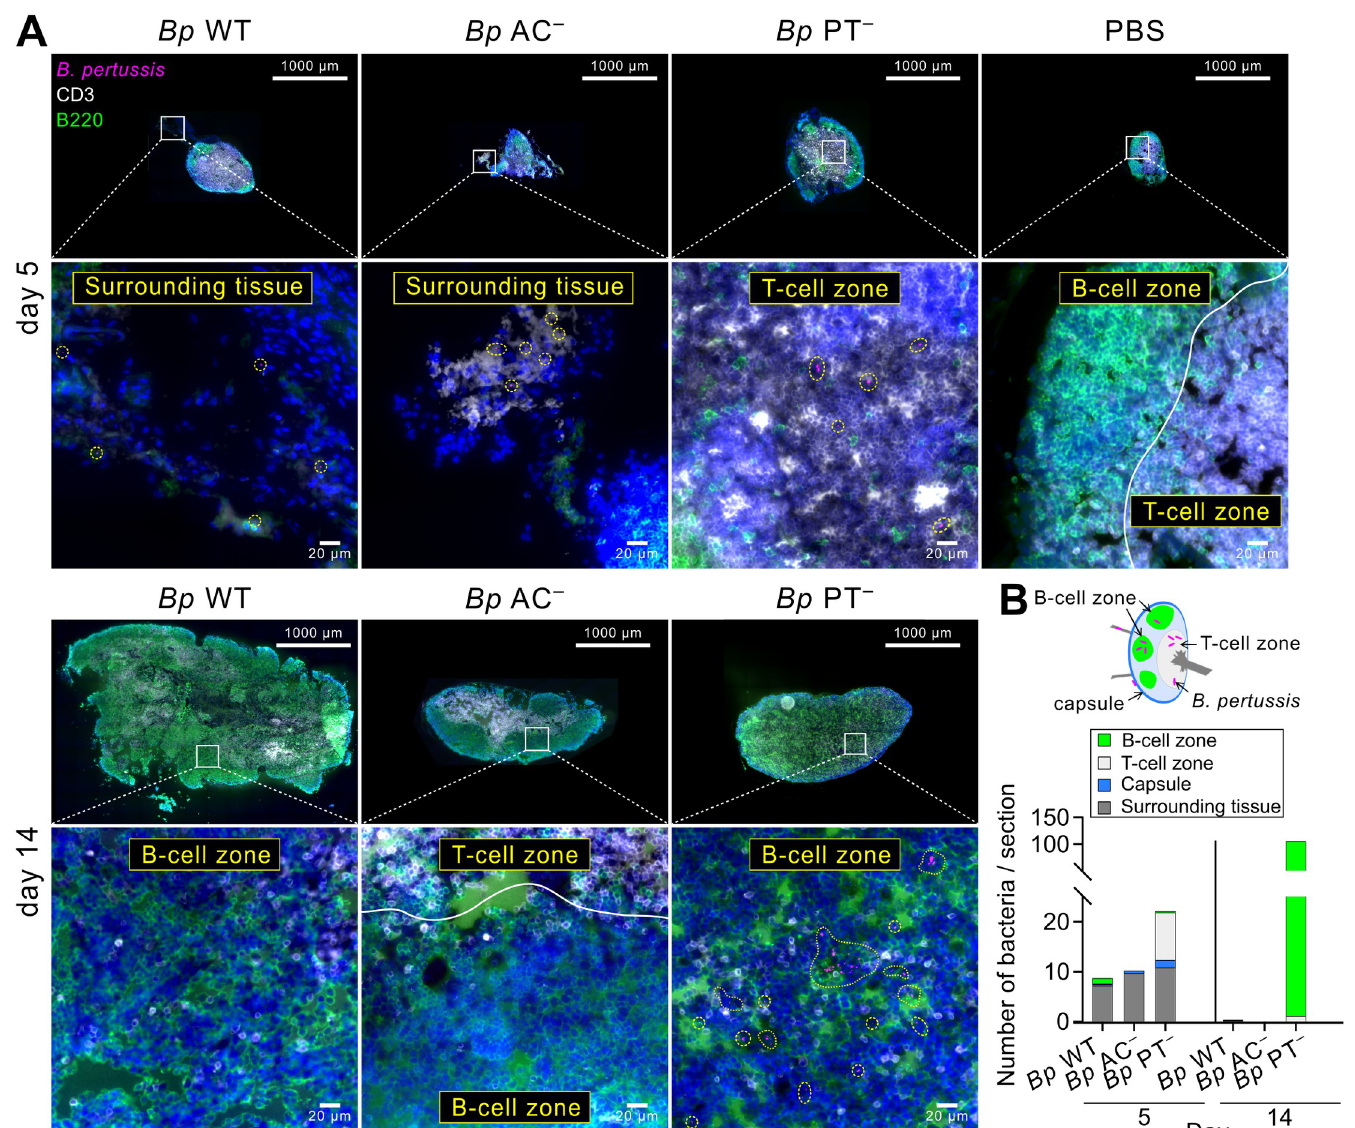
Fig 4. PT-producing B . pertussis does not enter the lymphoid tissue of mLNs, whereas Bp PT − bacteria enter the T-cell zone and expand in the B-cell zone of mLNs. (A) Immunofluorescence microscopy of cryosections of mLNs of infected mice on days 5 (upper panel) and 14 (lower panel). mLNs were fixed with 4% PFA, snap frozen and 10 μ m longitudinal cryosections were first labeled with rat anti-mouse CD45R (B220), followed by goat anti-rat Alexa Fluor 488 secondary antibody conjugate and finally by Alexa Fluor 647 rat anti-mouse CD3 antibody conjugate. Nuclei were labeled with DAPI. Stitched images were acquired at 40x magnification using an Olympus IX83 motorized automated microscope. Upper panels show representative images of entire mLN sections (scale bar 1000 μ m). The white squares locate the zoomed-in areas shown in lower panels (see S6, S7, S8 and S9 Figs for high resolution images). Lower panels depict the details of the indicated areas (scale bar 20 μ m). The mScarlet- expressing bacteria are encircled by yellow dotted lines. T cells, B cells, nuclei and bacteria are rendered in white, green, blue and magenta colors, respectively. In total 8 mLNs from three mice per infection group were examined and representative images are shown. (B) Location of bacteria on mLN sections. Individual bacteria were counted across entire mLN sections and location of bacteria in the indicated mLN zones (schematic drawing) was recorded. Mean bacterial counts of 6 mLN sections from 3 mice per infection group are shown.